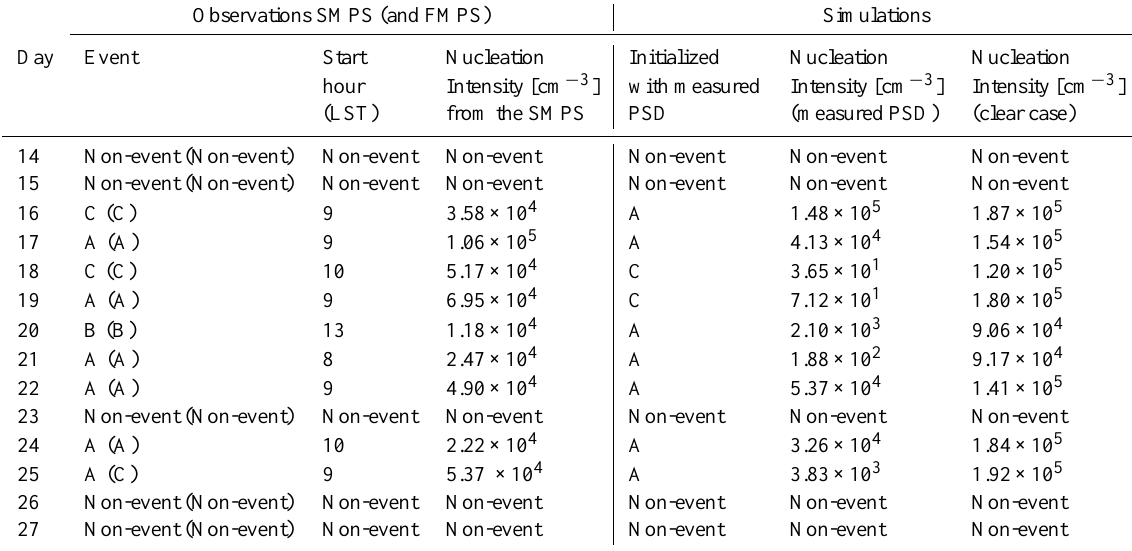
Table 1. Classification of event days at the MMSF site during the NIFTy experiment for 14–27 May based on the subjective classification of (Boy and Kulmala, 2002). The hour of maximum rate change of 10nm particle concentrations (start hour) is provided in local standard time (LST). Observed nucleation intensities [cm − 3 ], computed as the number of particles with diameter between 10 and 30nm in the two hours of highest concentration, are shown in the 4th column. The final three columns show model simulation results setting 250 sections and initializing the model with the measured particle size distribution (measured PSD) and clear atmospheric conditions (clear case) wherein the PSD is as described by (Seigneur et al.,